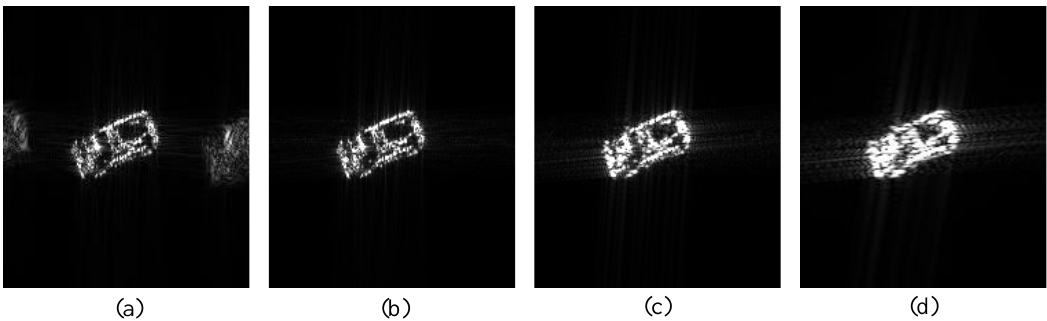
Figure 18. Refocusing results with different carrier frequencies, target speed is ( 5 × 5 ) m/s; ( a ) 5 GHz, ( b ) 10 GHz ( c ) 16 GHz, ( d ) 35 GHz.